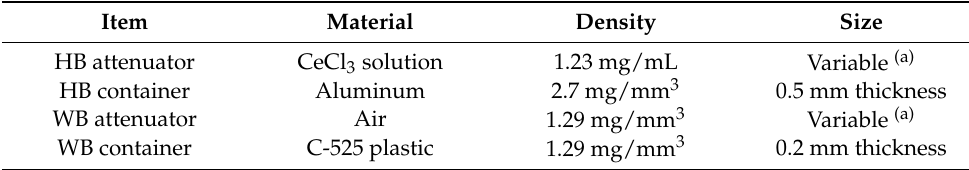
Table 1. Material composition inside of the FDB [27].